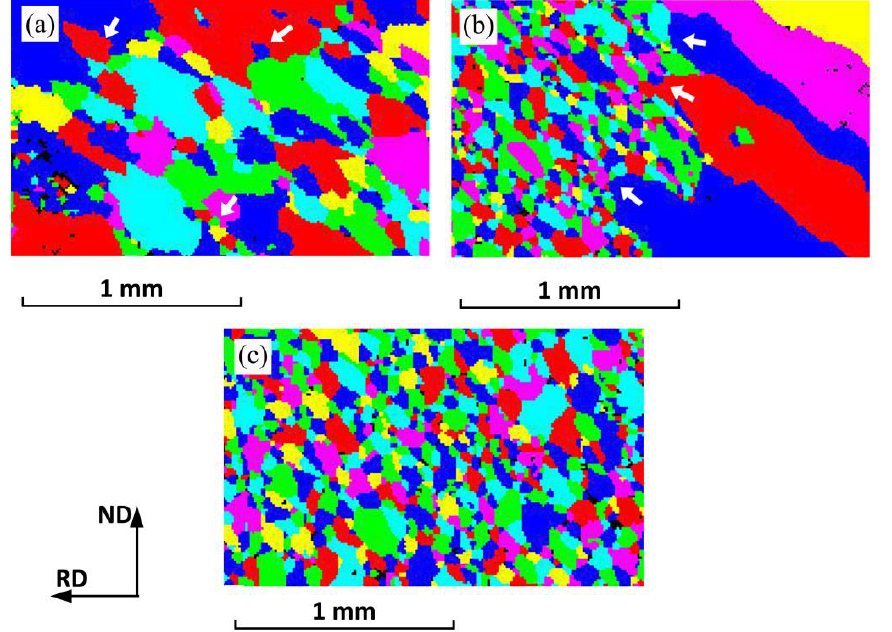
Figure 7. EBSD analysis of the three experimental alloys after brazing, ( a ) Sample A, ( b ) Sample B, ( c ) Sample C.